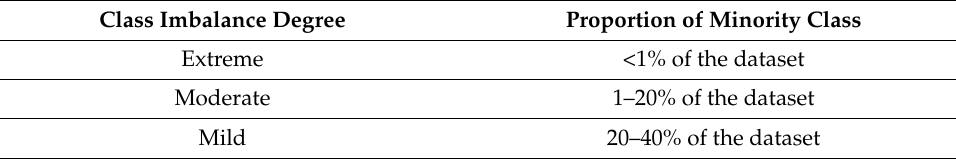
Table 2. Classification of degree of imbalance in